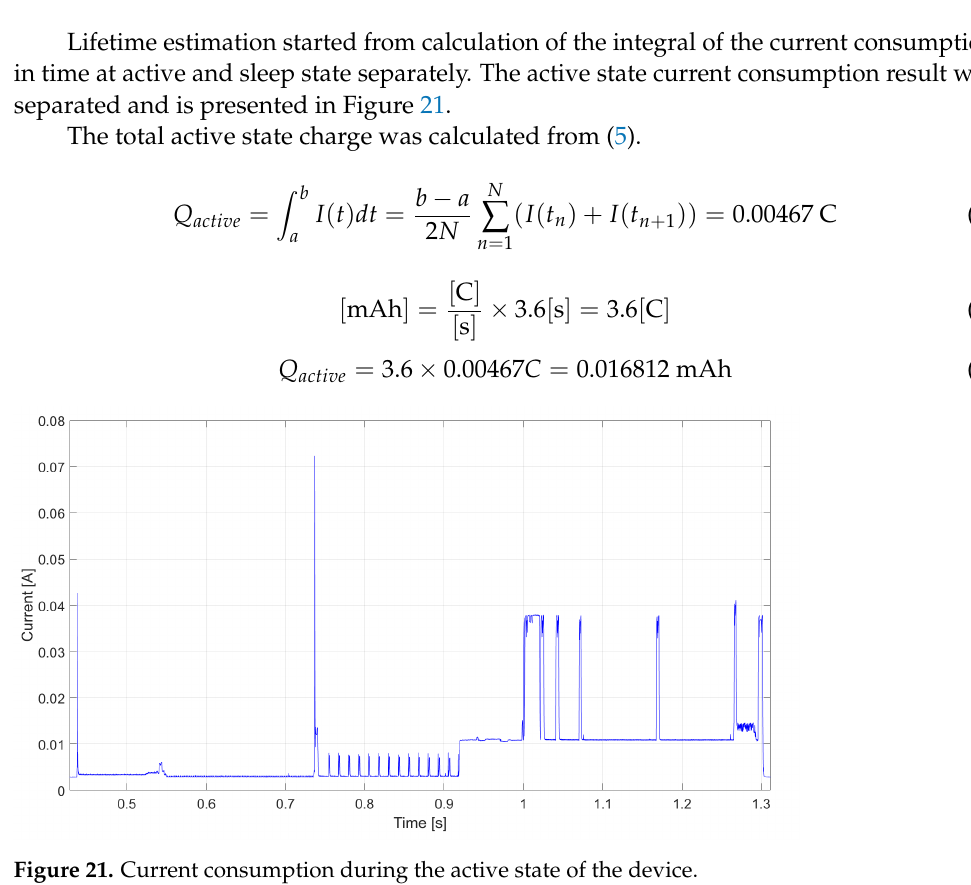
Figure 21. Current consumption during the active state of the